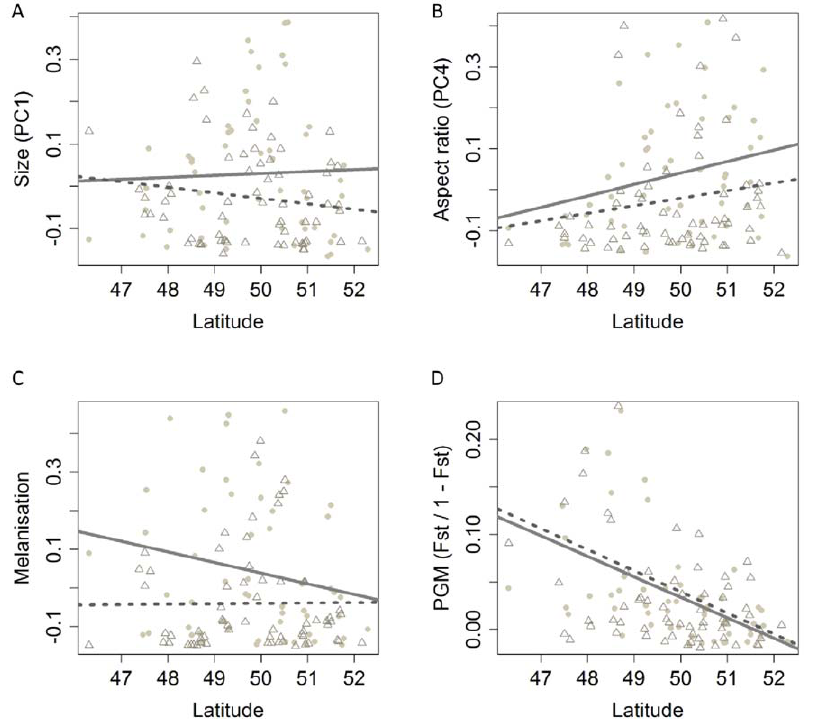
Figure 4. Pairwise population differentiation in relation to latitude and landscape. Residual phenotypic variation of (A) Size, (B) Aspect ratio, (C) melanization and residual genetic differentiation of (D) PGM. Full line: linear regression for agricultural-agricultural pairwise comparisons ( N ), dotted line: woodland-woodland pairwise comparisons ( D ). Significance levels are available in Table 2.